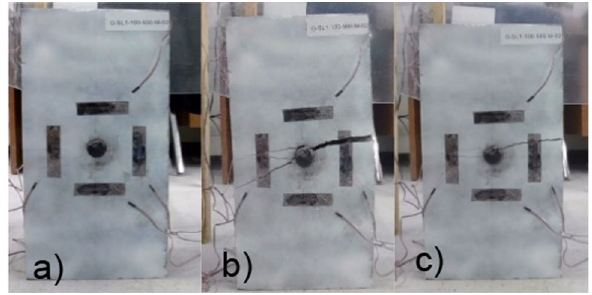
Fig. 5 G-SL1-100-500-M-02 a At time t Complete breakage at t 21